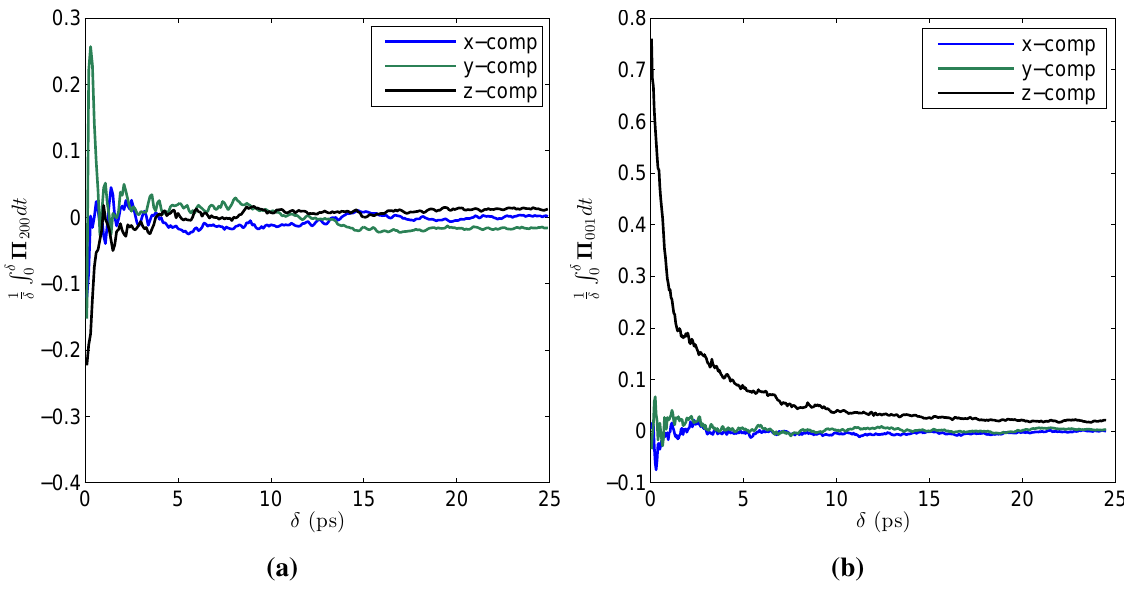
Figure 6. Evidence for the validity of the stationarity hypothesis shown via the convergence (cid:82) δ Π( t ) dt as a function of δ for coarse-grained (CG) variables selected from among of 1 δ 0 those used in simulating the contraction of N ω v. Initially, the integral experiences large fluctuations, since for δ small, only relatively few configurations are included in the time average constituting the integral, but as δ increases, the statistics improve and the integral becomes increasingly flat. ( a ) A plot of the time integral of Π for a high order CG Φ ( b ) a plot of the time integral of Π for a low order CG Φ